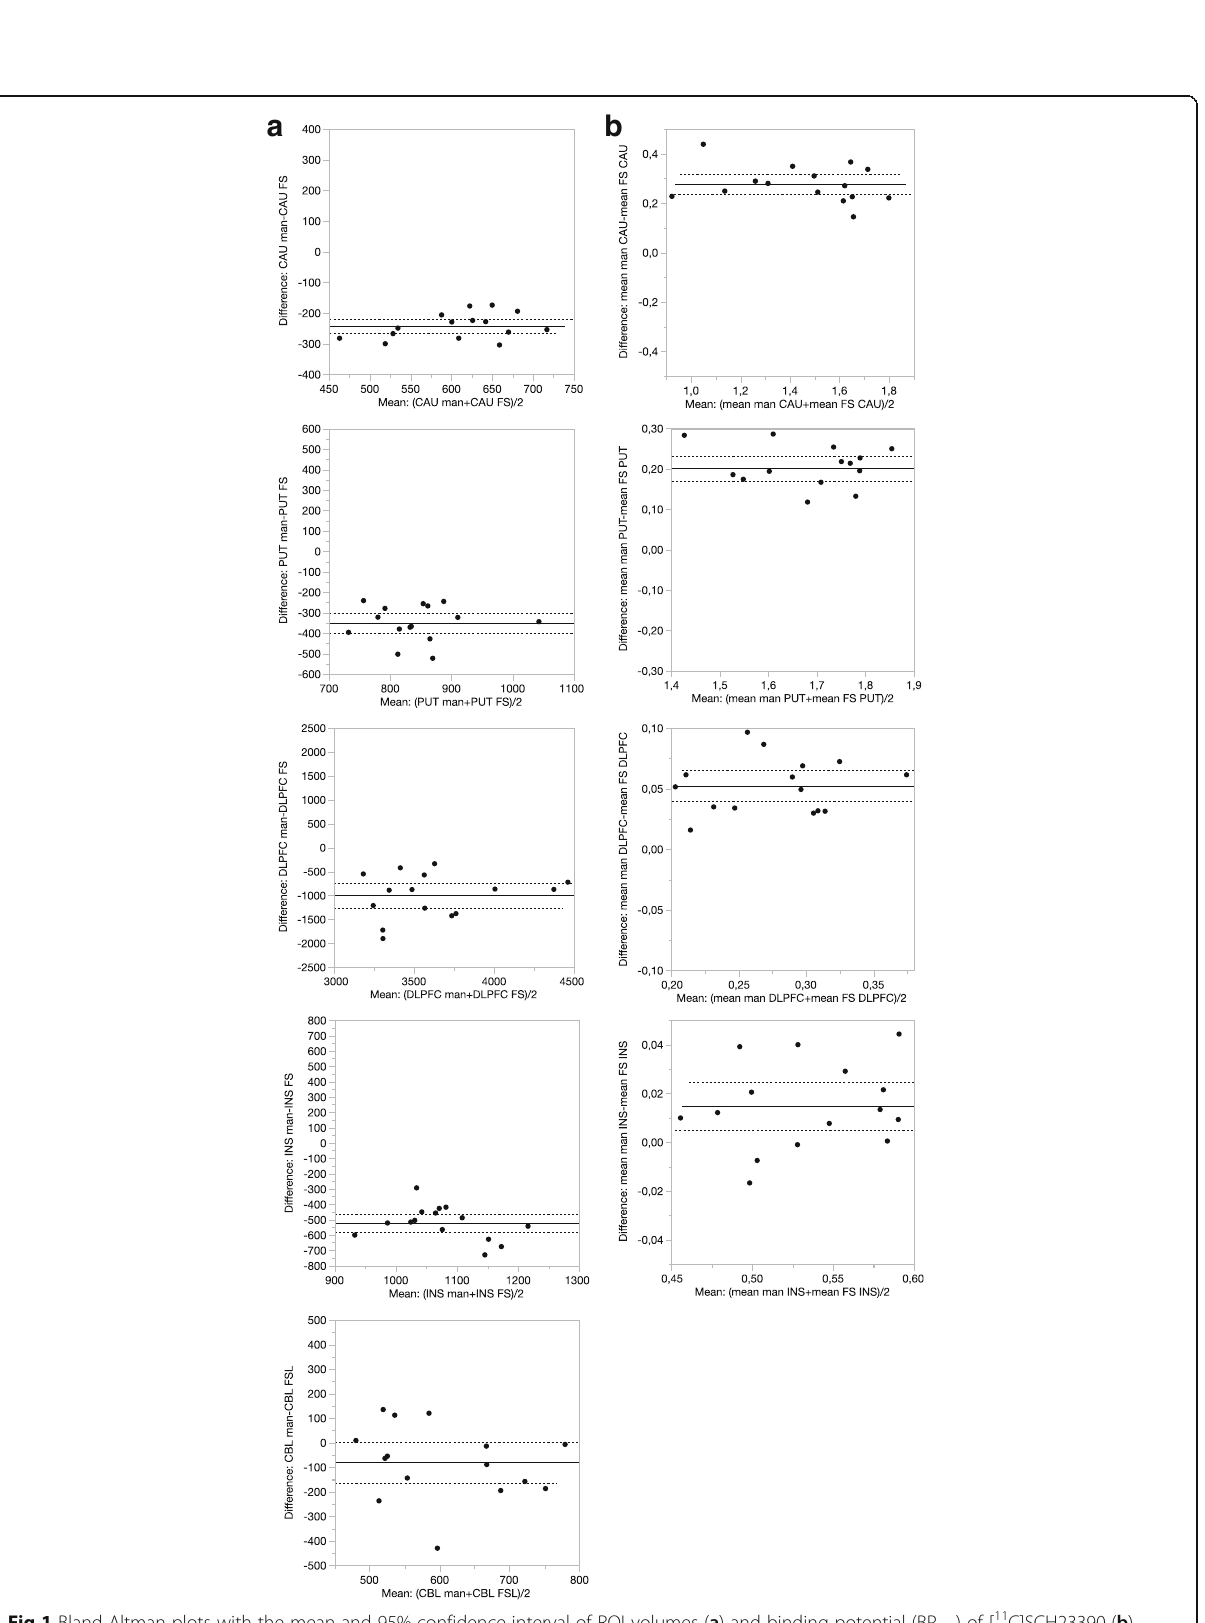
Fig 1 Bland-Altman plots with the mean and 95% confidence interval of ROI volumes ( a ) and binding potential (BP ND ) of [ 11 C]SCH23390 ( b ) of the caudate, putamen, dorsolateral prefrontal cortex, and insula derived from manual (man) and FreeSurfer (FS) methods. Man = manual, FS = FreeSurfer, CAU = caudate, PUT = putamen, DLPFC = dorsolateral prefrontal cortex, and INS =